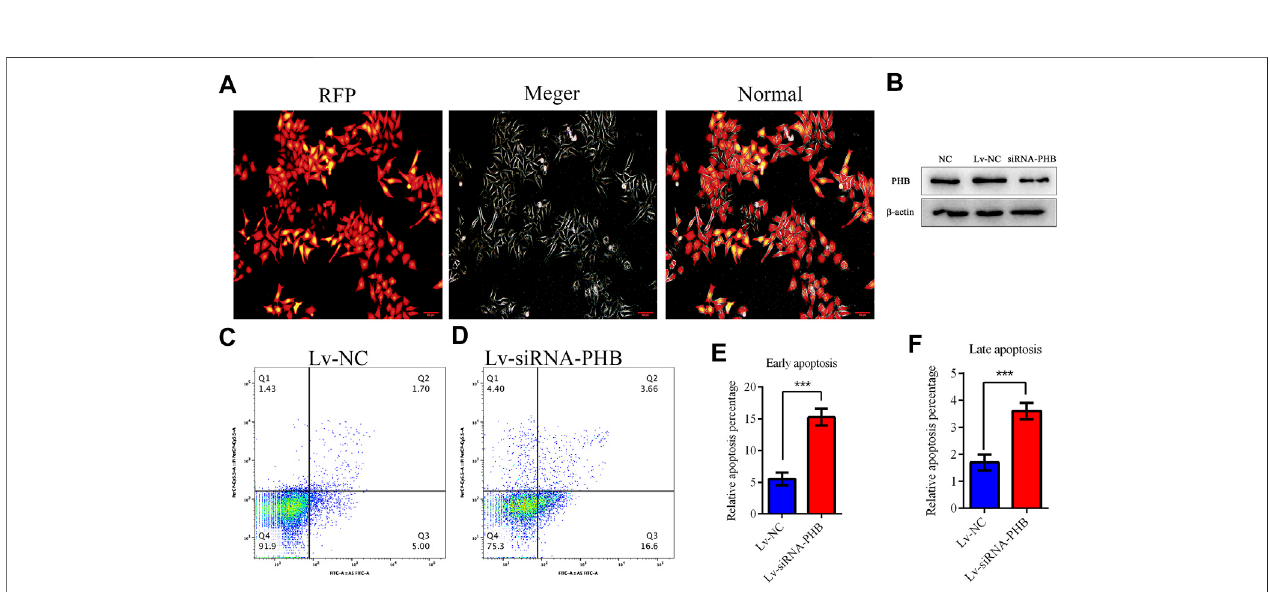
FIGURE6| PHBplaysakeyroleininducinghumangastriccancerAGScellapoptosis. (A) and (B) Lentivirus-mediatedinterference RNAcanknockdownthePHB expression in AGS cells. (C – F) PHB expression knockdown increased signi fi cantly, the apoptosis rate of AGS cells, indicating that PHB deletion can promote the apoptosis of these